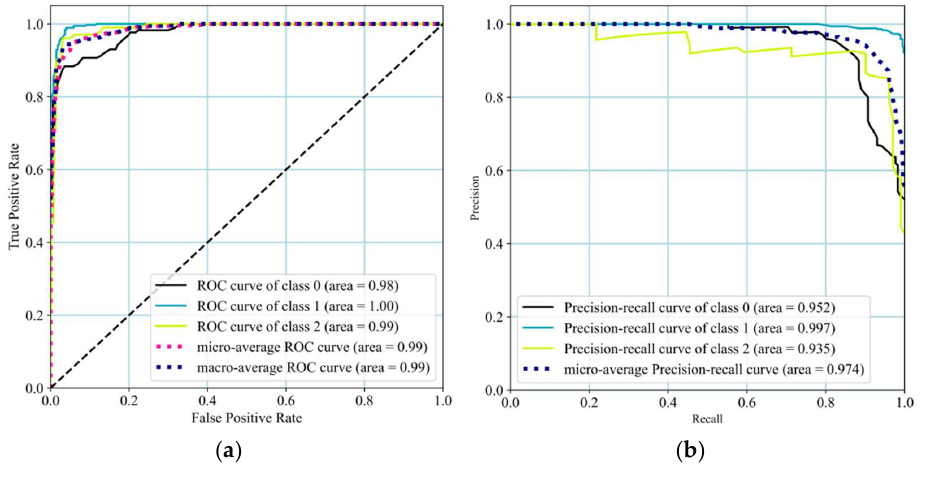
Figure 12. ROC and PR curves. ( a ) ROC curve, ( b ) PR curve.